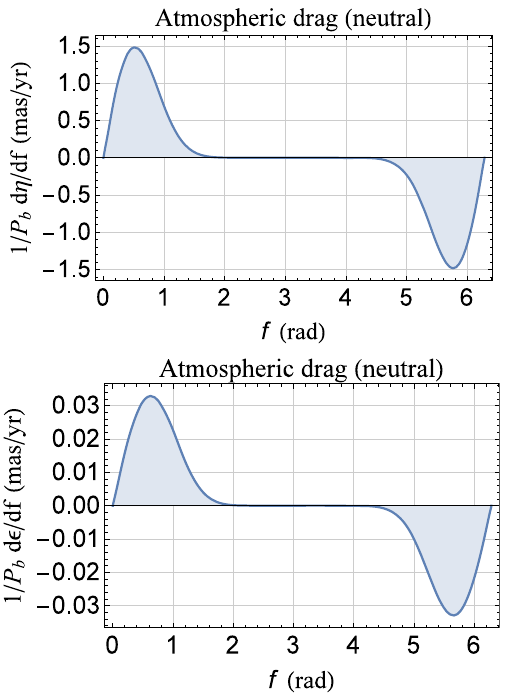
Fig. 5 Plots of Eqs. (61) and (62), computed for the orbital configura- tion of Table1 and with f 0 = 228 ◦ , over a full orbital cycle of the true anomaly f . Their areas